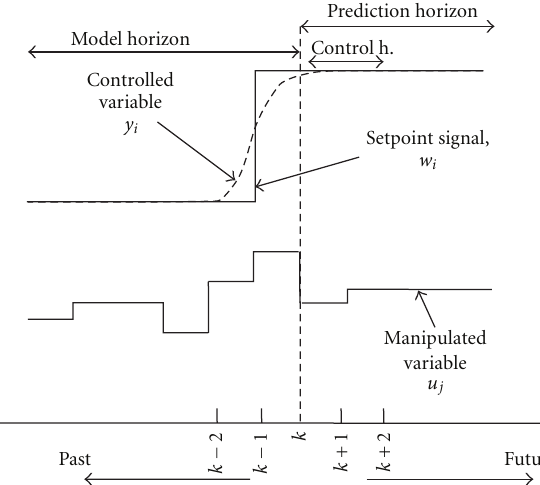
Figure 3: Illustration of essence of MPC in control of y i by manipulating u j